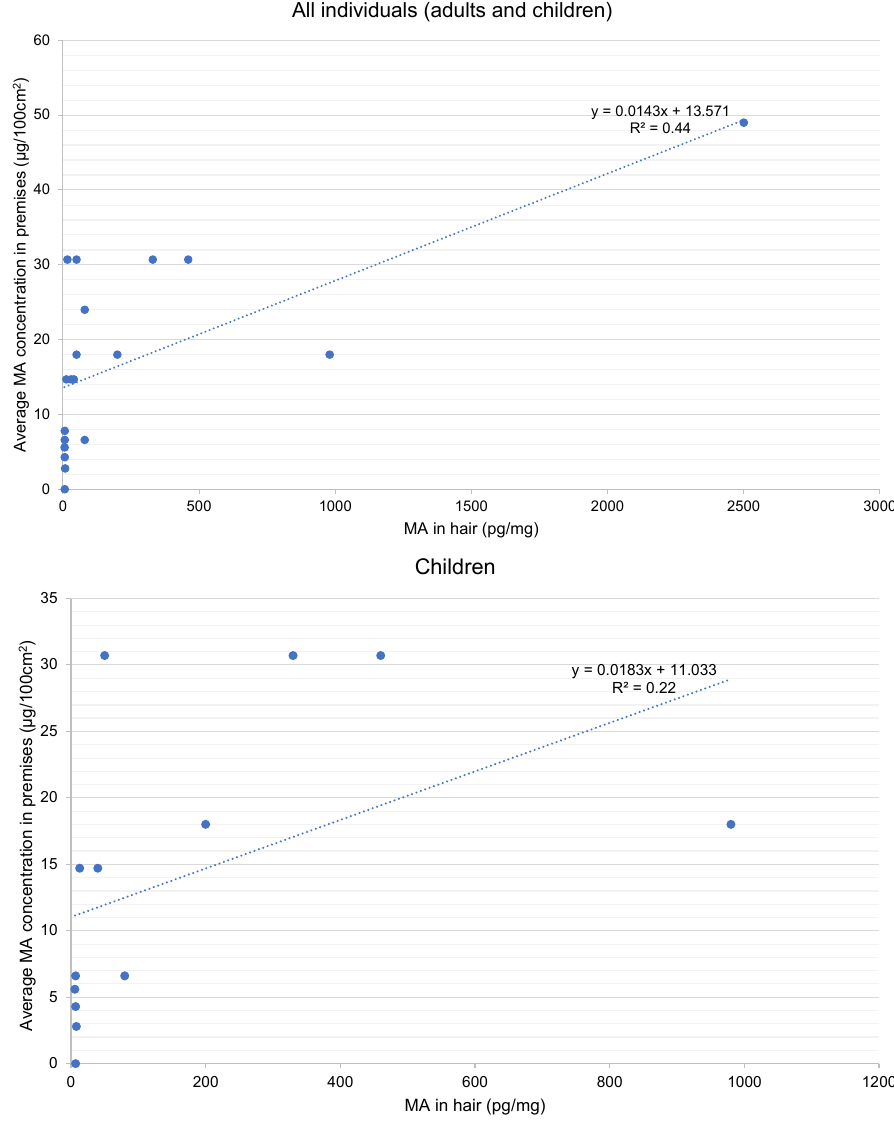
Figure 1. Relationship between environmental methamphetamine (MA) in individual premises and in hair samples collected from individuals exposed in these properties.